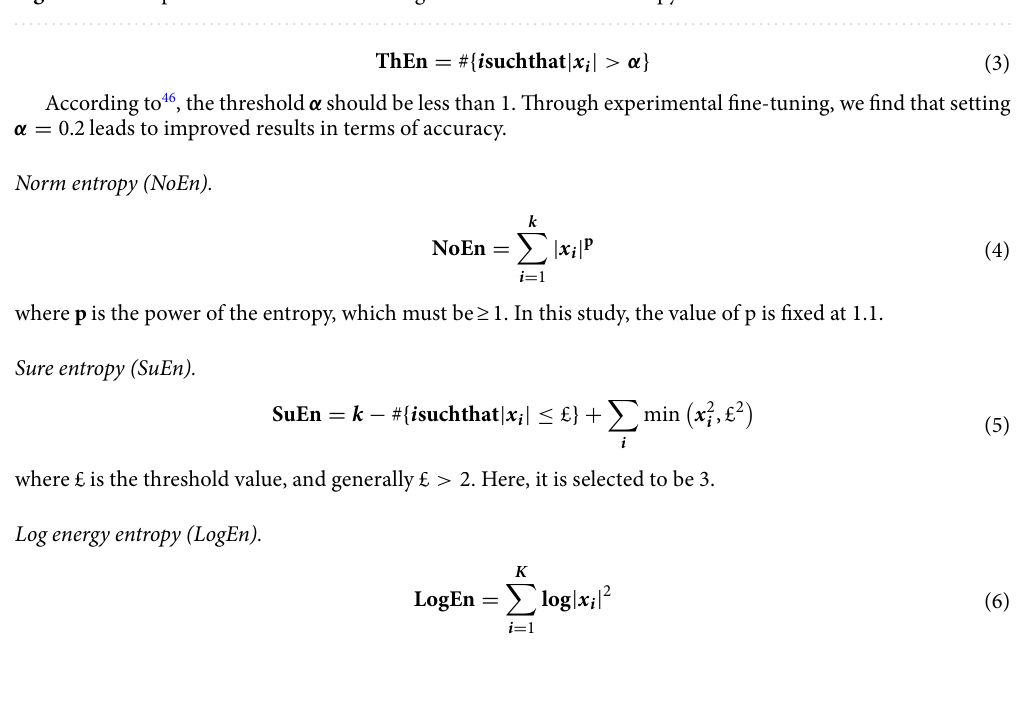
Figure 4. Example of feature extraction using DWT and Shannon